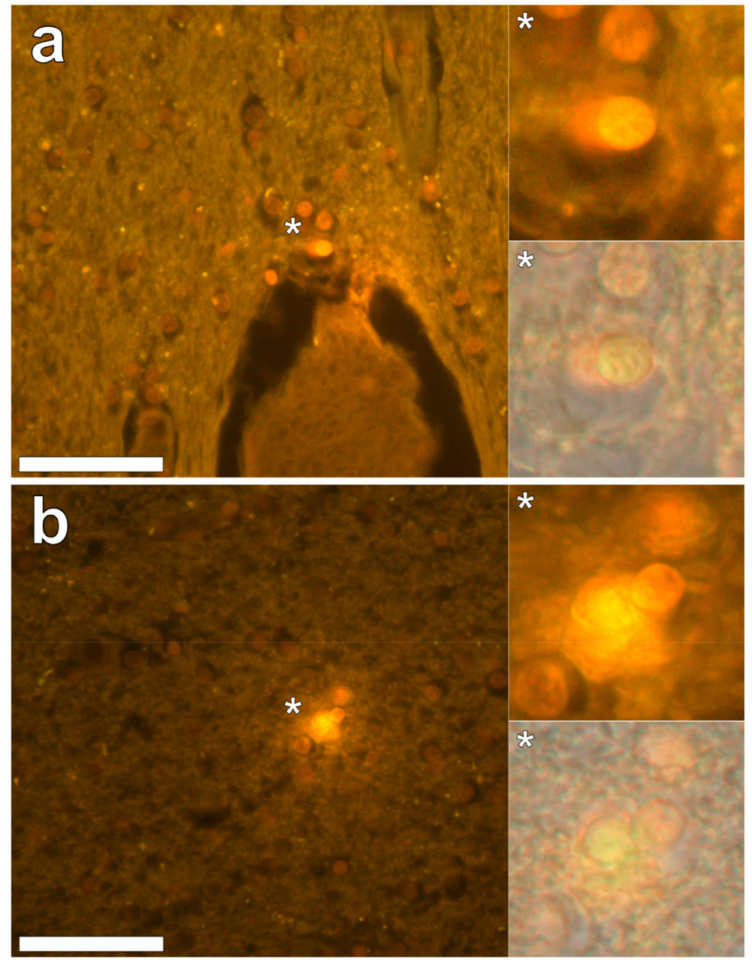
Figure 5. Lumogallion-reactive aluminium in glial cells in white matter of the parietal lobe. Intracellular bright orange fluorescence was noted in glial cells surrounding vasculature ( a ) and in areas depicting cellular debris ( b ). Magnified inserts are denoted by asterisks with lower panels including a bright field overlay. Magnification 400 × ; scale bars 50 µ